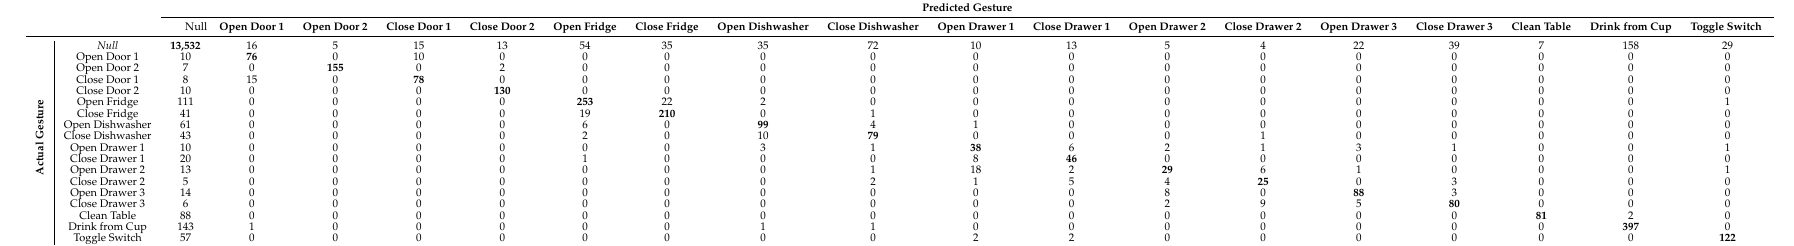
Table 5. Confusion matrix for OPPORTUNITY dataset using DeepConvLSTM.